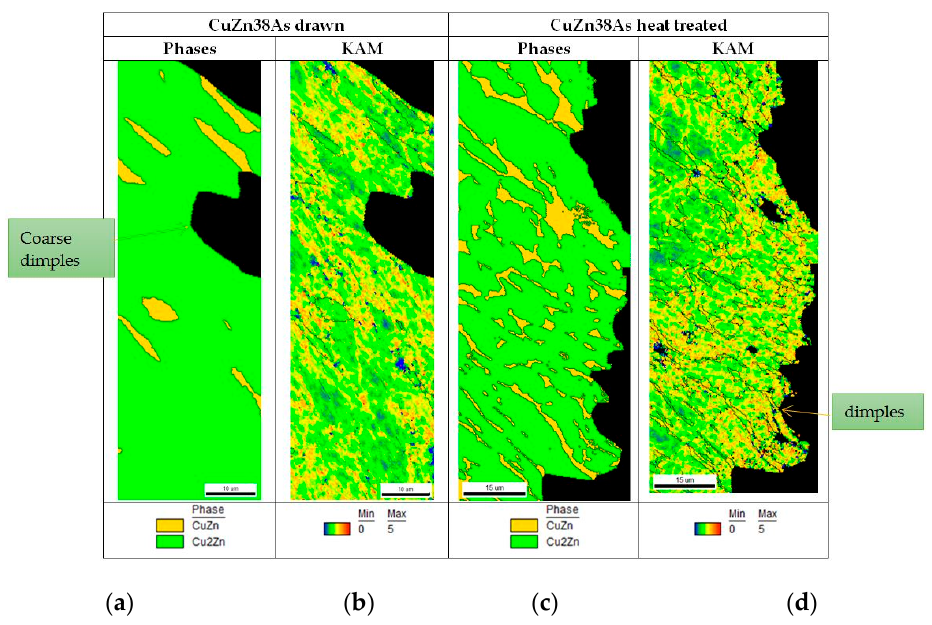
Figure 9. Phase and KAM maps of the fracture surface profile of Charpy impact tested CuZn38As alloy samples in the ( a , b ) as-drawn and ( c , d ) heat treated conditions. Unit: µ m.